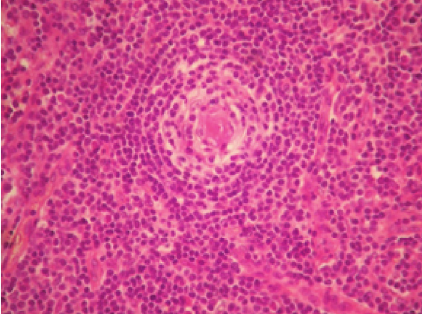
Figure 2: The “onion-skinning features” in some follicles of the adjacent parenchyma mimicked the Castleman disease (HE ×